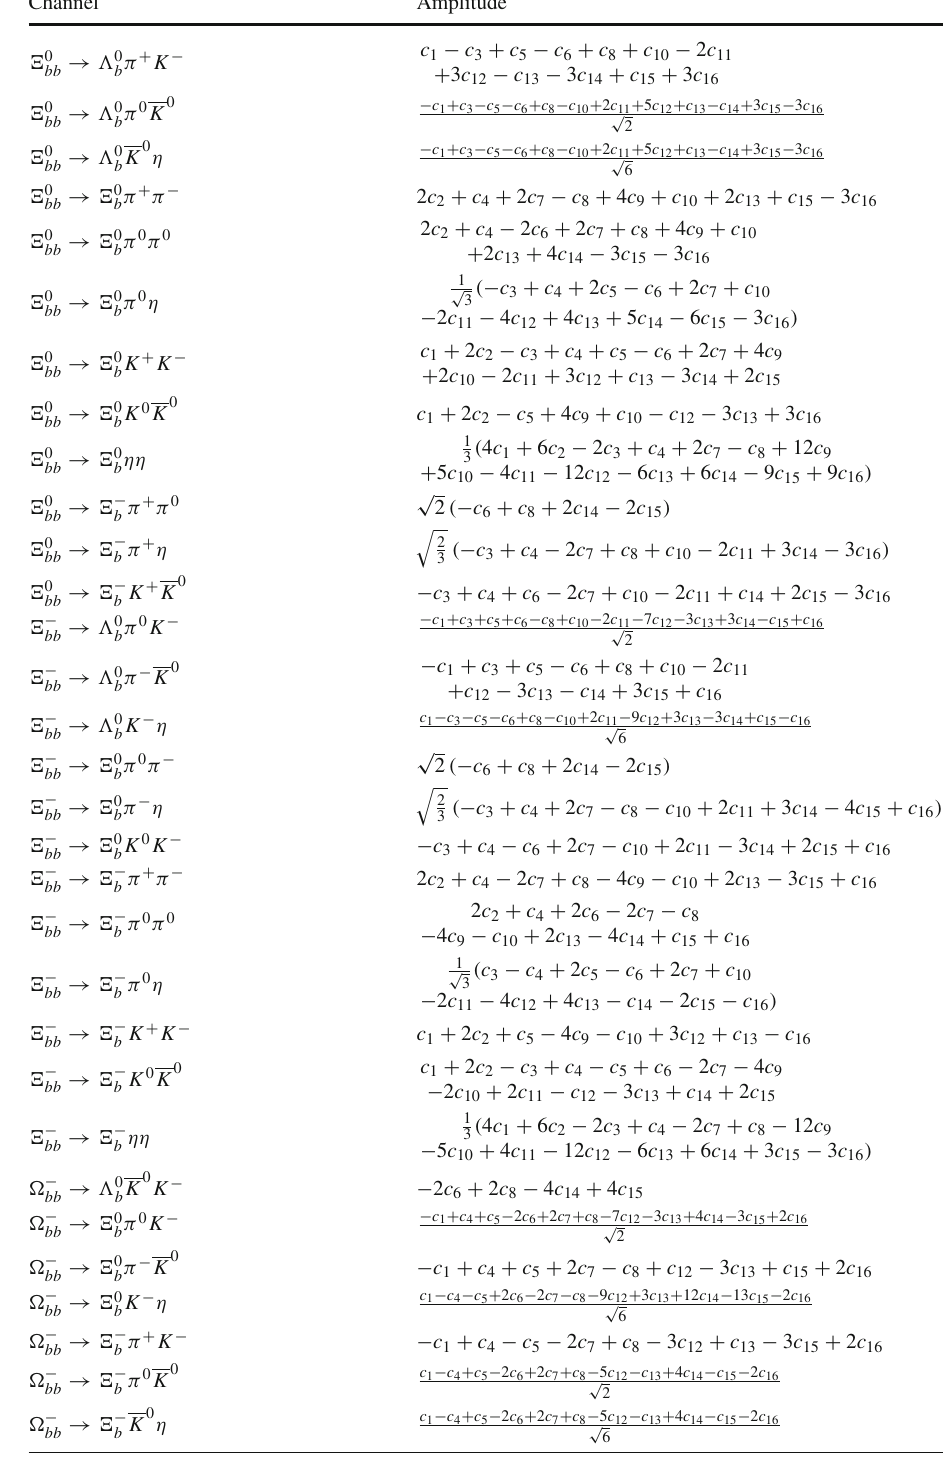
Table 23 Doubly bottom baryon decays into a bqq (anti-triplet) induced by the charmless b → s transition and two light